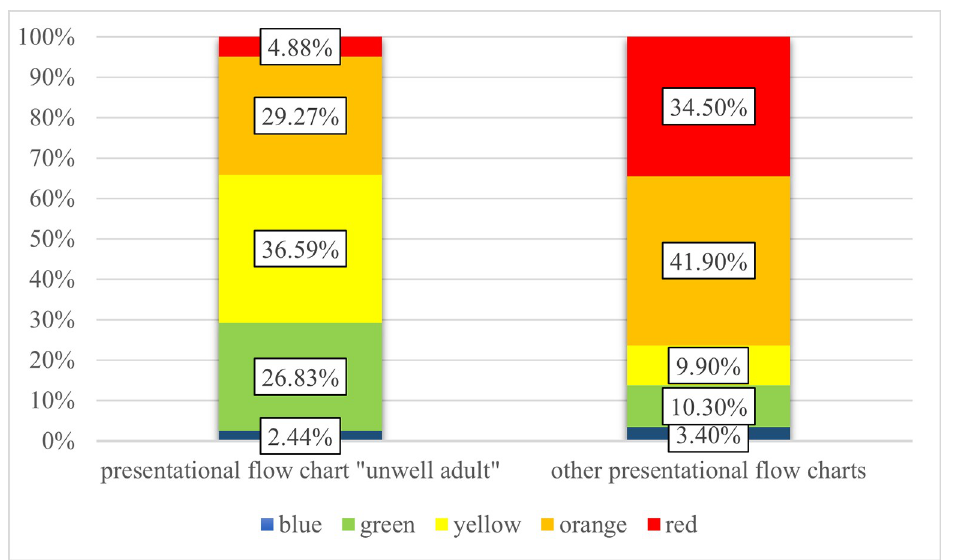
Fig 7. The different MTS urgency levels used in the in-hospital deceased patients triaged according to the presentational flow chart “unwell adult” vs. the deceased patients of the other presentational flow charts (p <